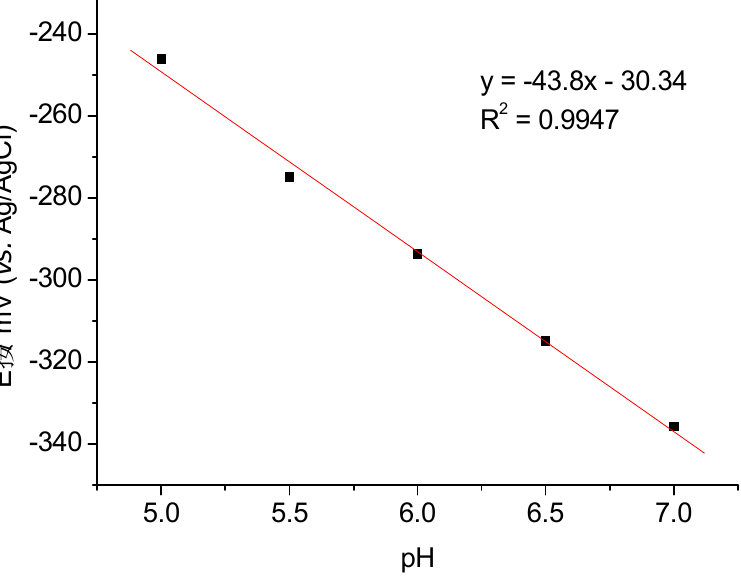
Figure 4. Formal potentials of MP-11 immobilized in a matrix of chitosan embedded AuNPs at GCE at pHs between 5 and 7 at 100